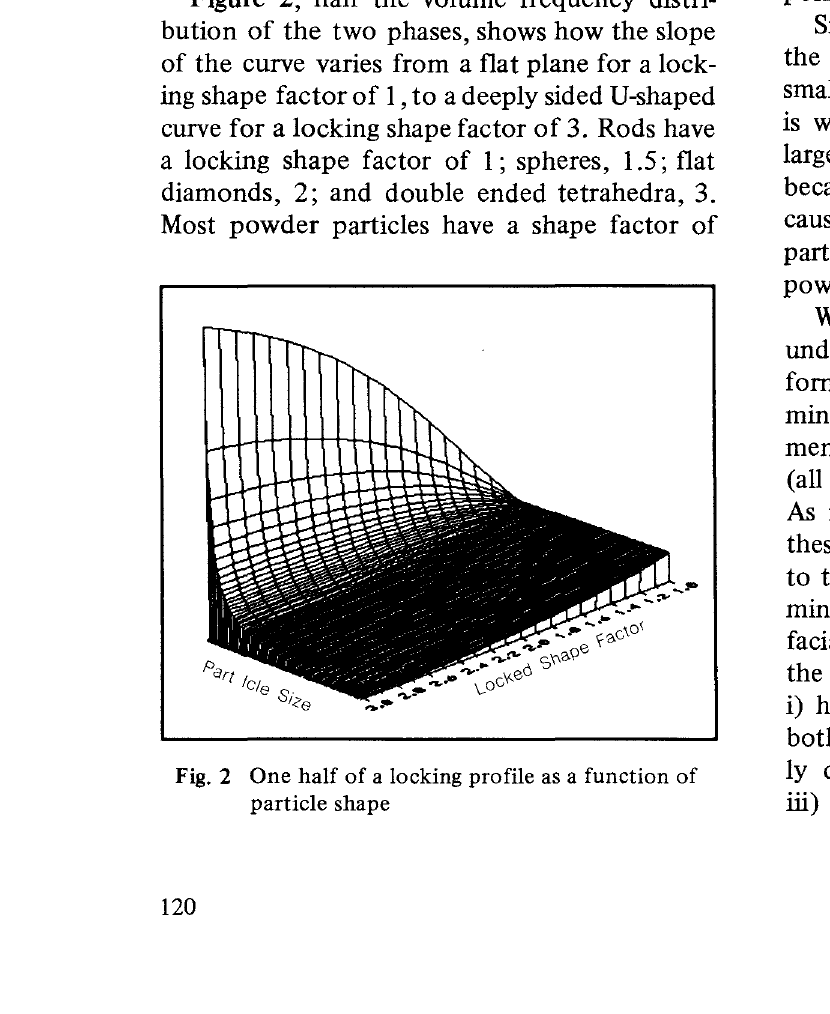
Fig. 2 One half of a locking profile as a function of particle